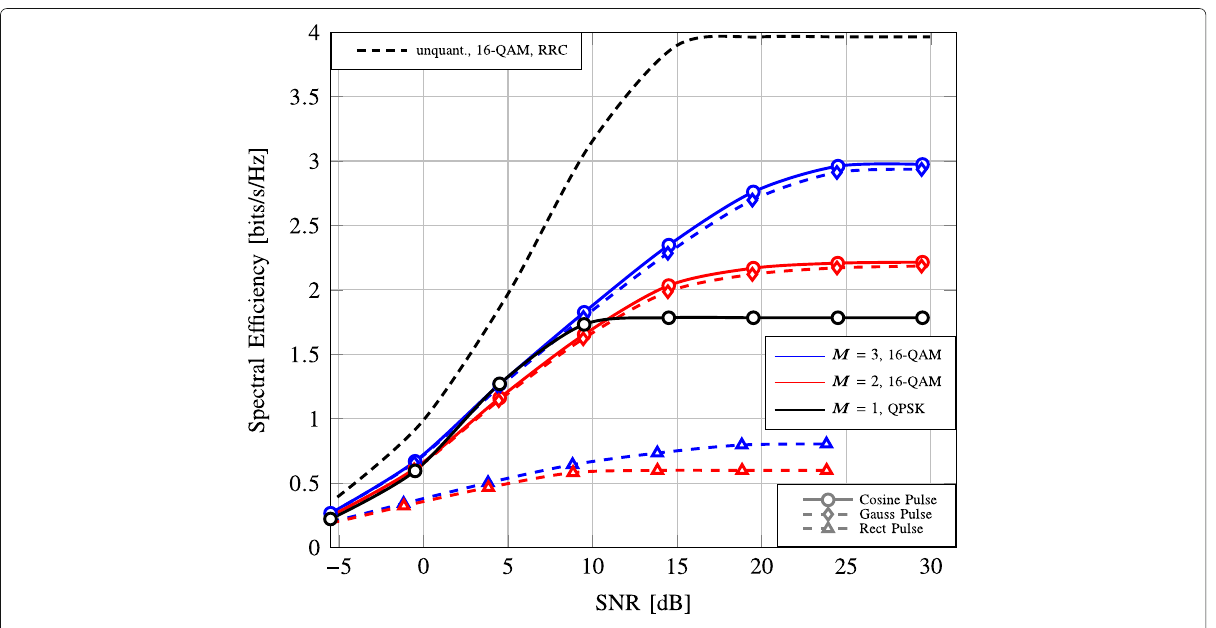
Fig. 8 The spectral efficiency w.r.t. B 95% for different transmit pulses